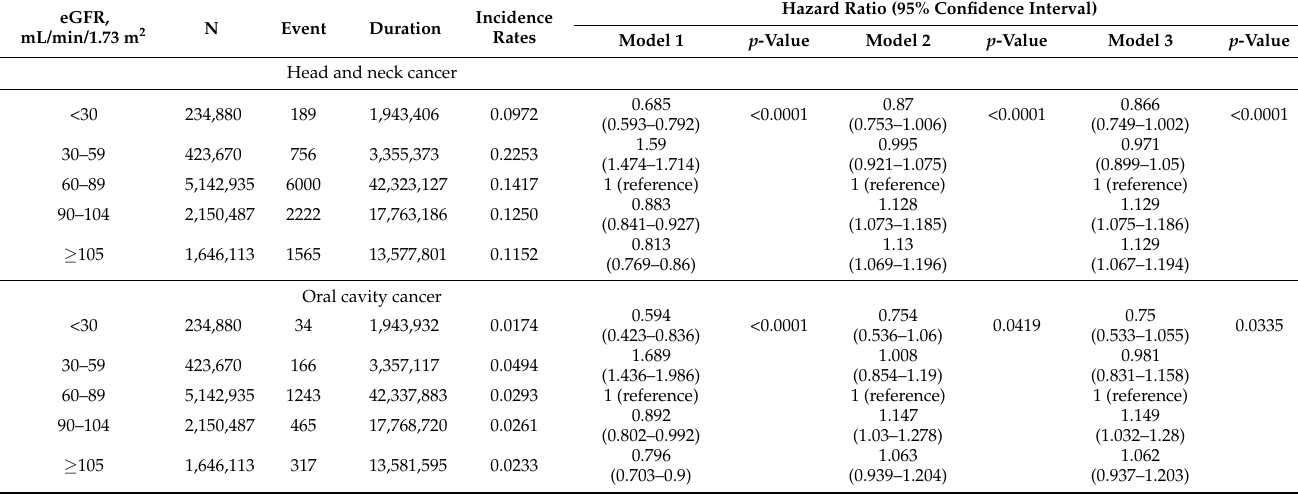
Table 2. Hazard ratios of head and neck cancer and its subtypes according to the estimated glomerular filtration